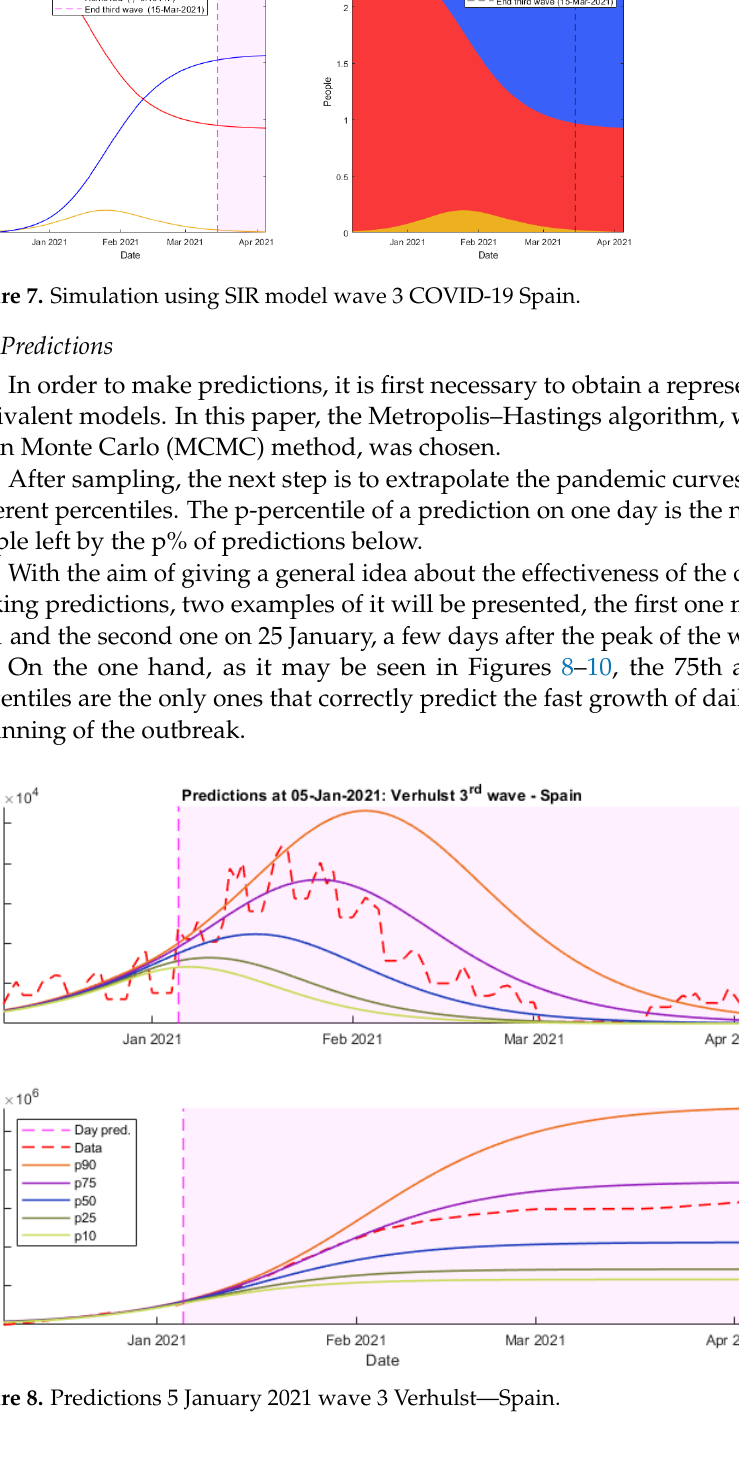
Figure 6. Fit using SIR model wave 3 COVID-19 Spain.